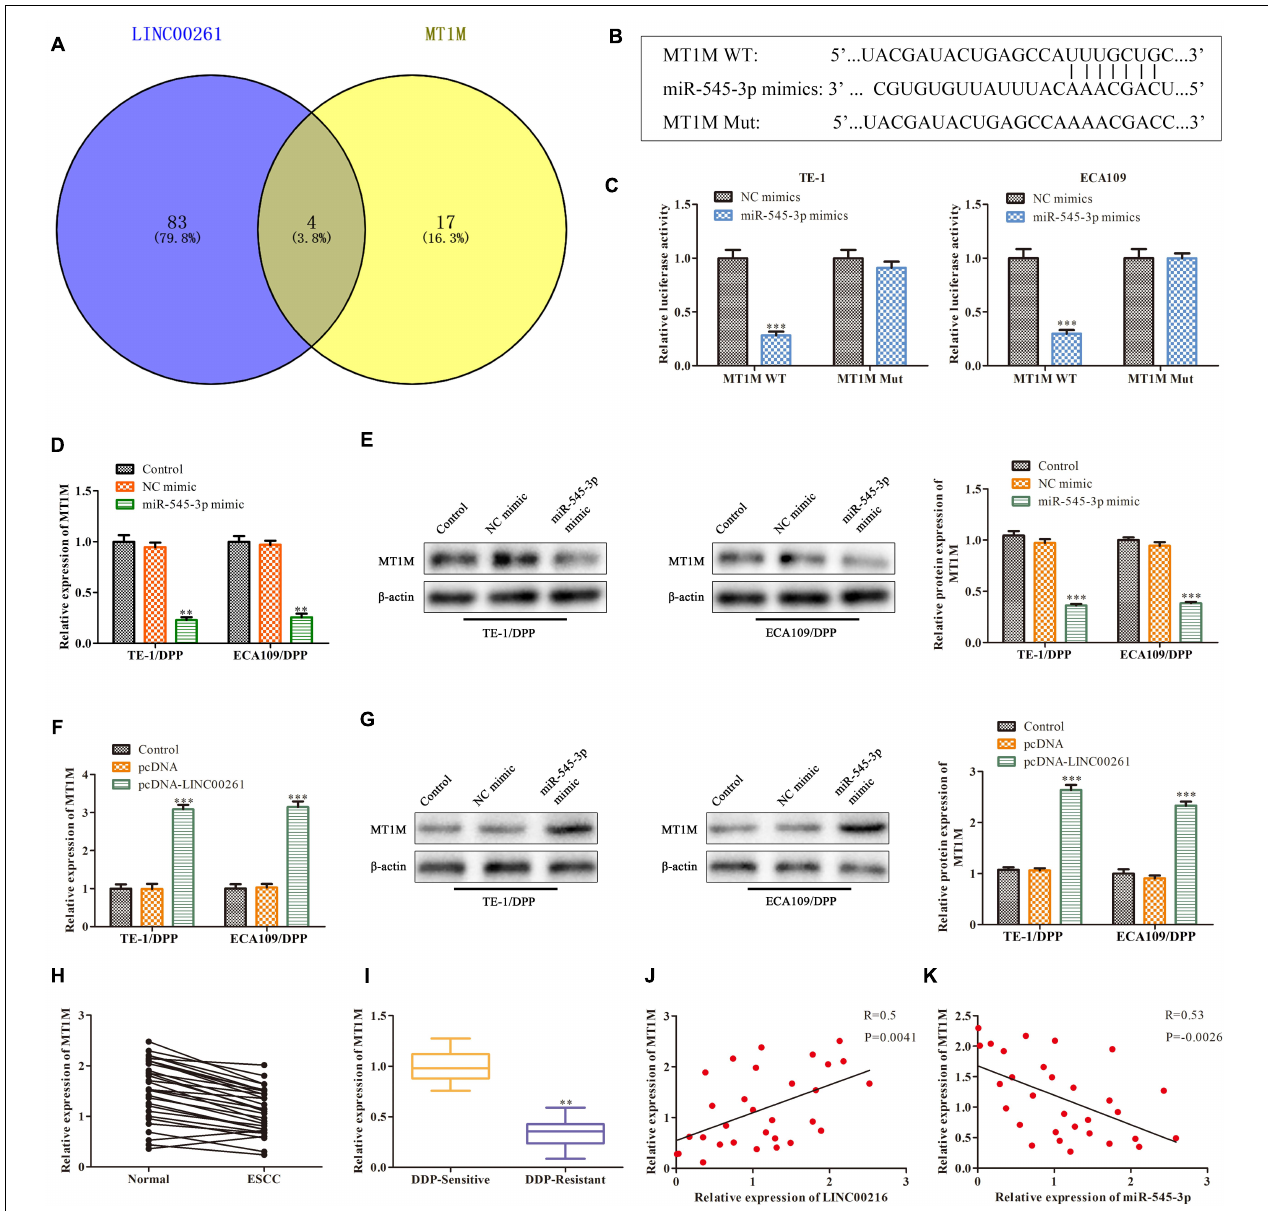
FIGURE 6 | MT1M is a target gene of miR-545-3p. (A) The target gene of miR-545-3p predicted by Bioinformatics websites. (B) The binding sites between miR-545-3p and MT1M. (C) The interaction between miR-545-3p and MT1M testified by luciferase reporter assay. (D) The mRNA level of MT1M detected by RT-qPCR in miR-545-3p mimics treated cells. (E) The protein level of MT1M measured by western blot in miR-545-3p mimics treated cells. (F) The mRNA level of MT1M detected by RT-qPCR in pcDNA-LINC00261 treated cells. (G) The protein level of MT1M measured by western blot in pcDNA-LINC00261 treated cells. (H) The expression of MT1M in ESCC tissues and adjacent tissues. (I) The expression of MT1M in DDP-sensitive and DDP-resistant ESCC patients. (J) Pearson’s correlation analysis demonstrated the correlation of LINC00261expression with MT1M. (K) Pearson’s correlation analysis demonstrated the correlation of miR-545-3p expression with MT1M. ** P < 0.01, *** P < 0.001 compared with the corresponding control